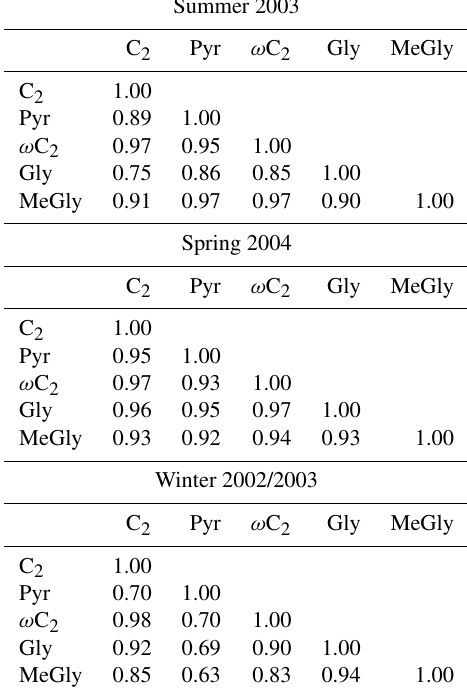
higher-generation products of isoprene in the presence of relatively high NO x (i.e., NO x averaged to 6.6 ± 4.0 ppbv in summer and 3.9 ± 3.3 ppbv), which could serve as precur- sors of oxalic acid over China. Oxalic acid also significantly correlates with α/β -pinene-SOA tracers (i.e., pinonic, pinic, 3-hydroxyglutaric, and 3-methyl-1,2,3-butanetricarboxylic acid) and β -caryophyllene tracer ( β -caryophyllinic acid, see Fig. 4) (Jaoui et al.,